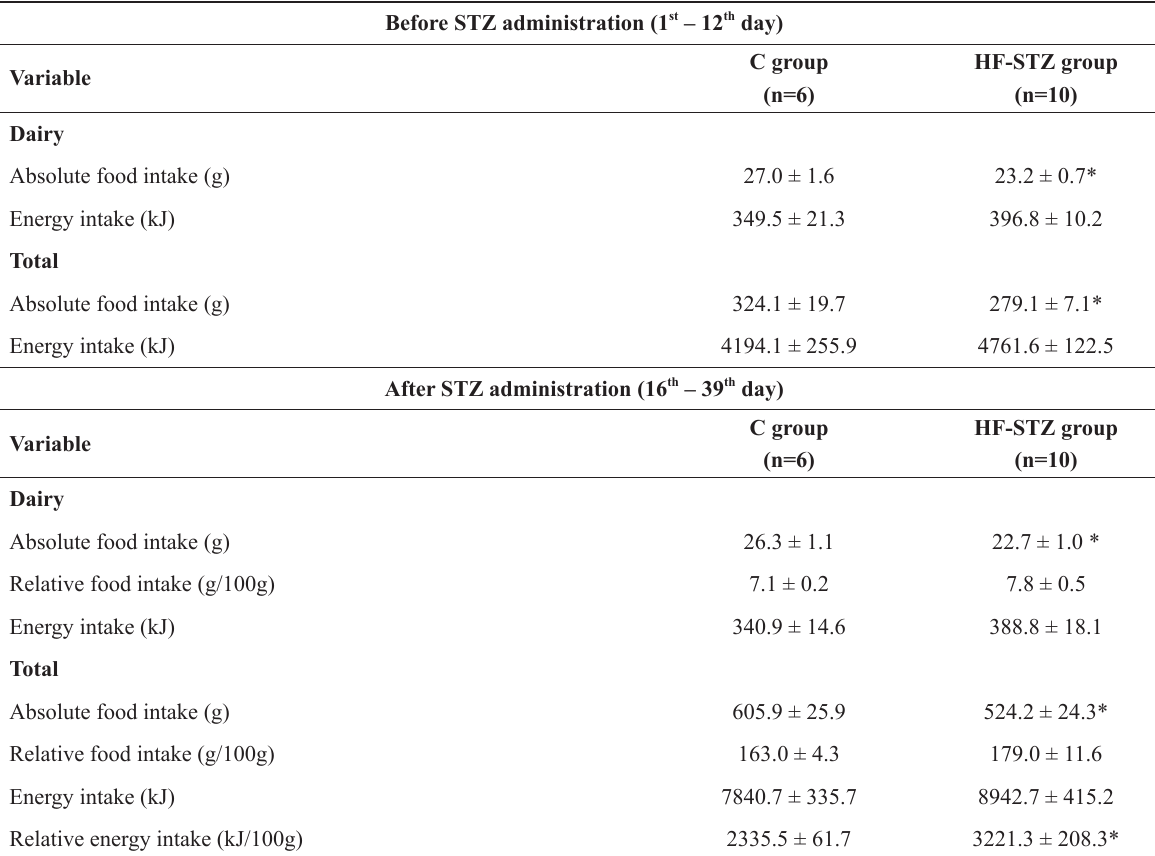
Total and dairy absolute food intake and total and dairy energy intake of male rats subjected to control diet (C) or high- fat diet/ streptozotocin (HF-STZ) before and after streptozotocin (STZ)